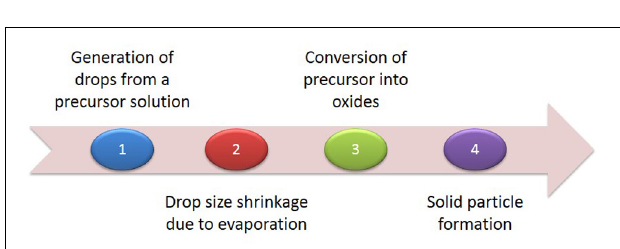
FIGURE 4 | The four major steps of pyrolysis.